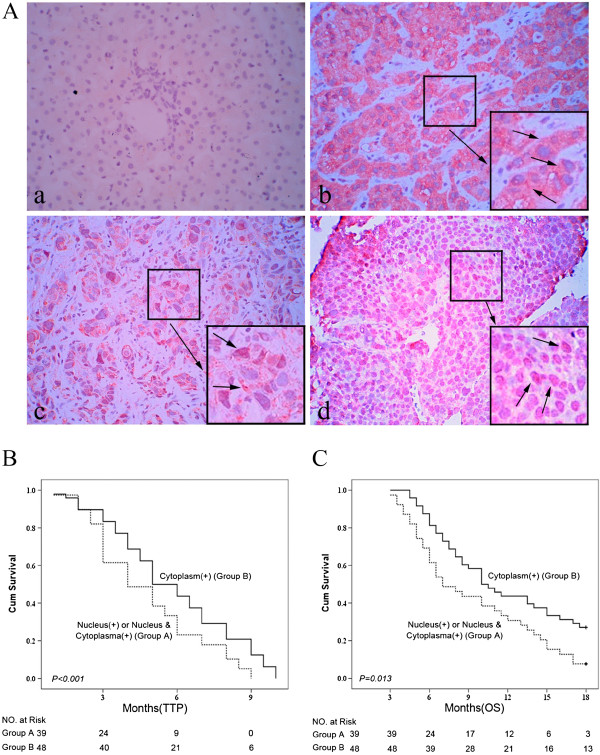
Nuclear expression of MACC1 protein and overall survival after cryoablation therapy. A. The expression of MACC1 protein detected by immunohistochemistry (×400). a. Normal control liver tissue showed a weak MACC1expression in cytoplasm. b. A HCC case showed a mainly cytoplasmic MACC1 expression in tumor tissue (arrowhead). c. Another case with both weak cytoplasmic and sporadic nuclear MACC1 expression(arrowhead). d. The predominant nulear MACC1 expression in the tumorous tissue of a HCC patient (arrowhead). B. Kaplan–Meier estimates of time to progression in patients with nuclear MACC1 expression vs. those with cytoplasmic MACC1 expression (p < 0.001). C: Kaplan–Meier estimates of overall survival time in patients with nuclear MACC1 expression vs. those with cytoplasmic MACC1 expression (p < 0.01).